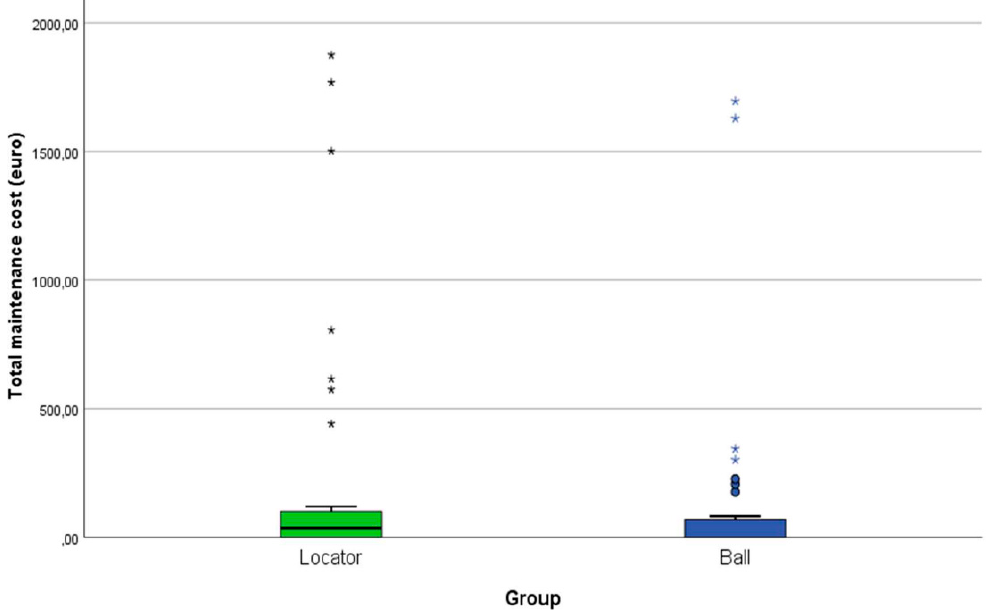
Figure 3. Cumulative amount of maintenance costs in relation to the initial treatment costs. No significant difference observed between both treatment groups ( p = 0.540). * and o represent the outliners.